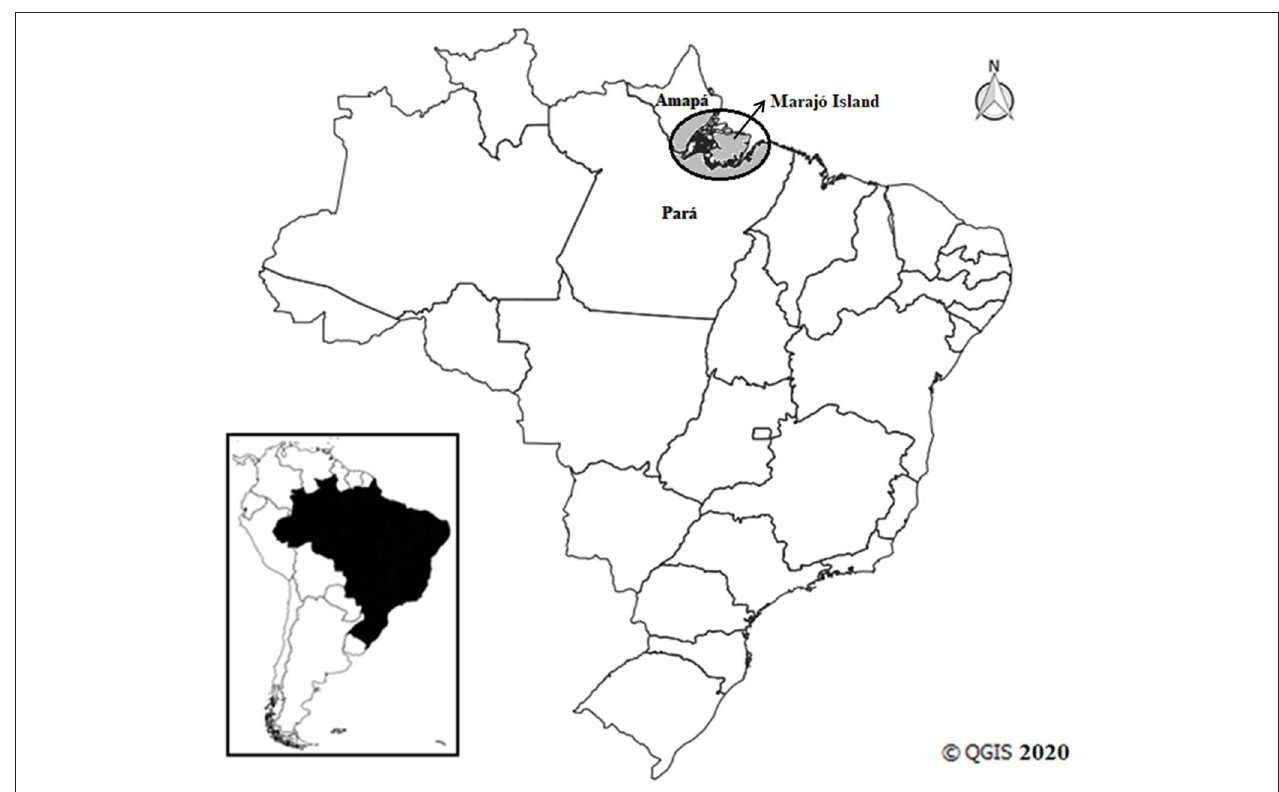
FIGURE 1 | Amazon River Delta region in Brazil